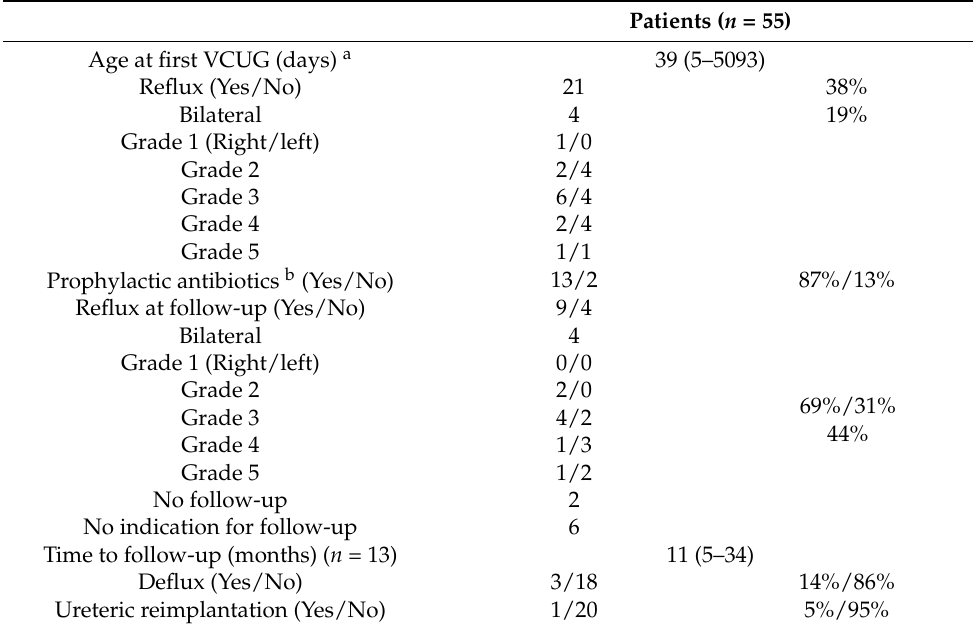
Table 3. The presence of vesicoureteral reflux (VUR), antibiotic treatment, follow-up, and surgery in 55 patients with spina